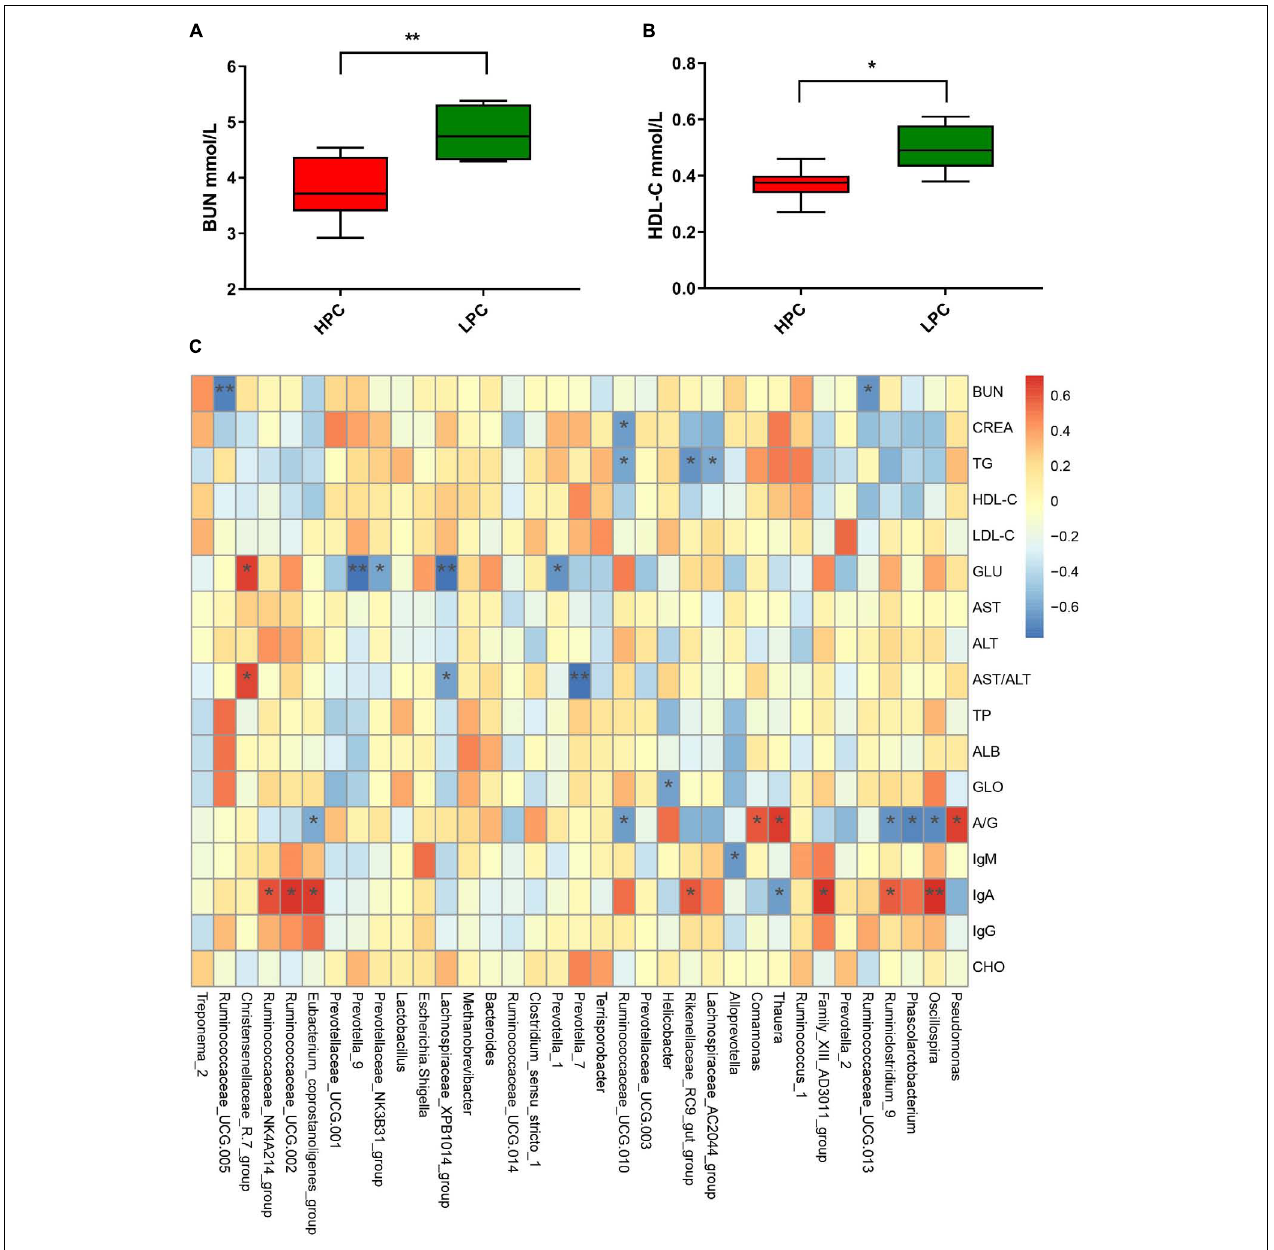
FIGURE 7 | Serum biochemical indices differences in sows and correlations with gut microbial abundance during early stage after parturition. (A) Blood urea nitrogen (BUN, n = 6). (B) Serum high-density lipoprotein cholesterol (HDL-C, n = 6). (C) Heatmap of correlations between gut microbial abundance and serum biochemical indices at genus level. Paired T -test (LP vs. EAP) or independent T -test (HPC vs. LPC) was used after accessing normality with Shapiro–Wilk W -test to analyze serum biochemical indices differences. The correlations between microbial abundance at the genus level and serum biochemical indices were evaluated